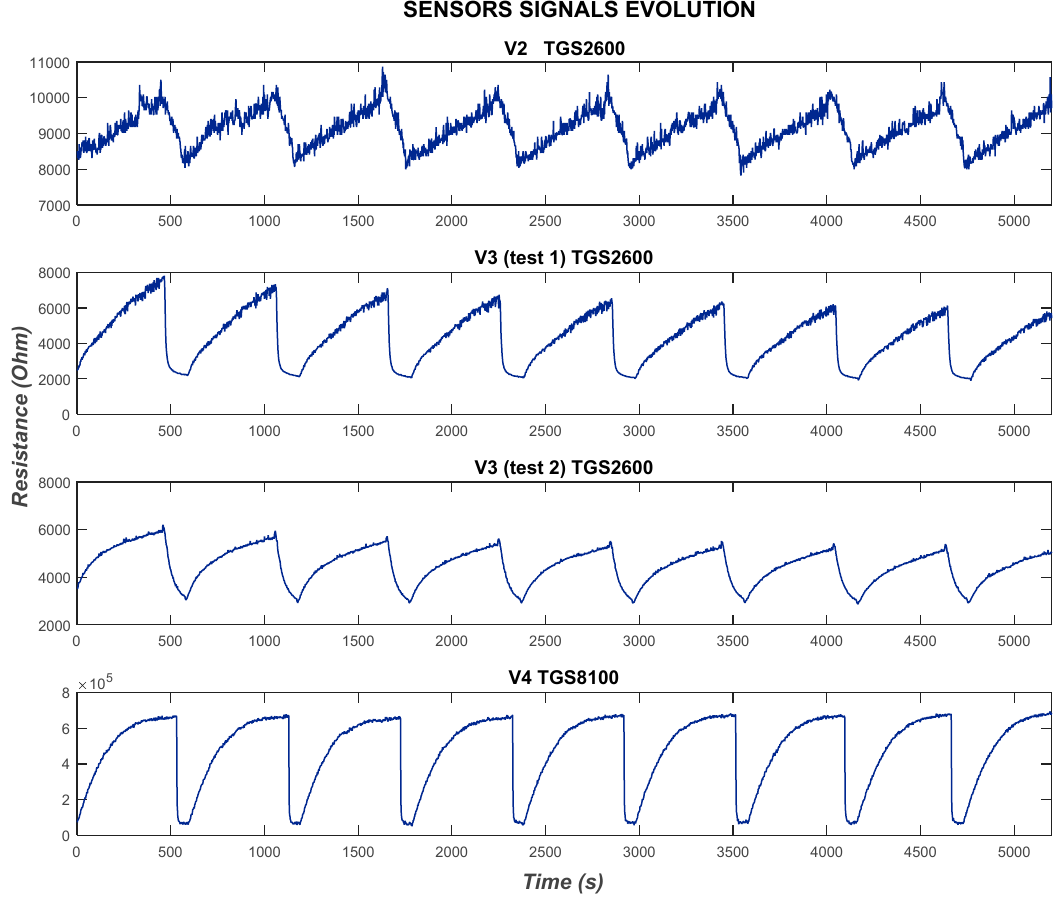
Figure 11. Evolution of sensor signals (resistance versus time), corresponding to the eight xylene measurements.